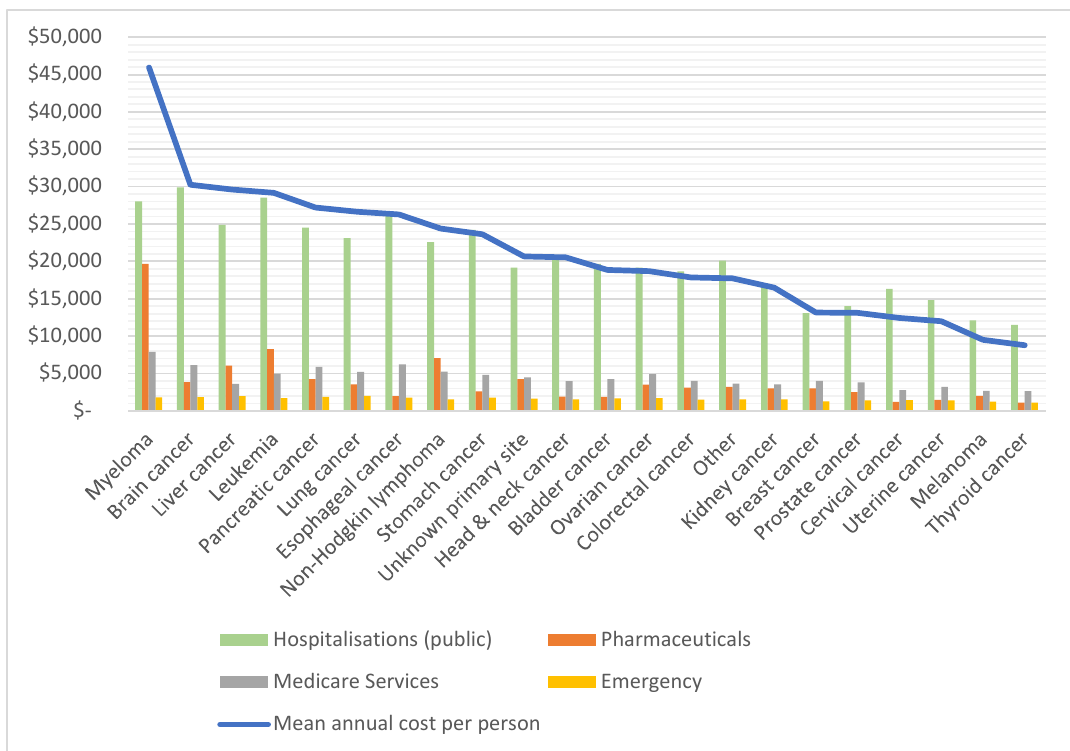
Figure 6. Mean annual healthcare costs per person (2013–2016) in AU$ by cancer type and health service component.